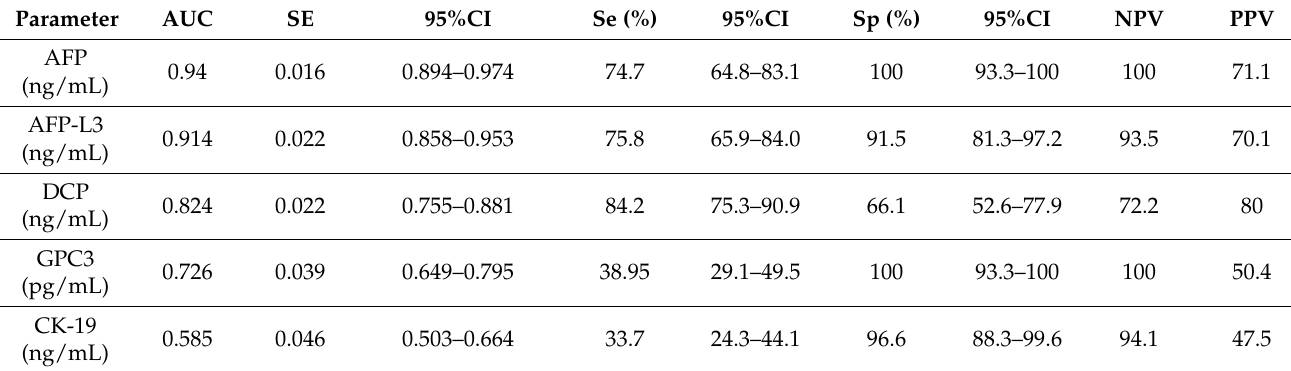
Table 3. Performance of serum biomarkers for predicting the presence of